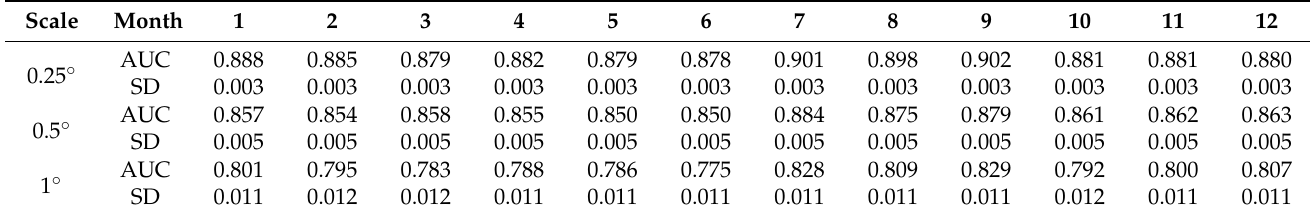
Table 1. Summary statistics derived from different models.